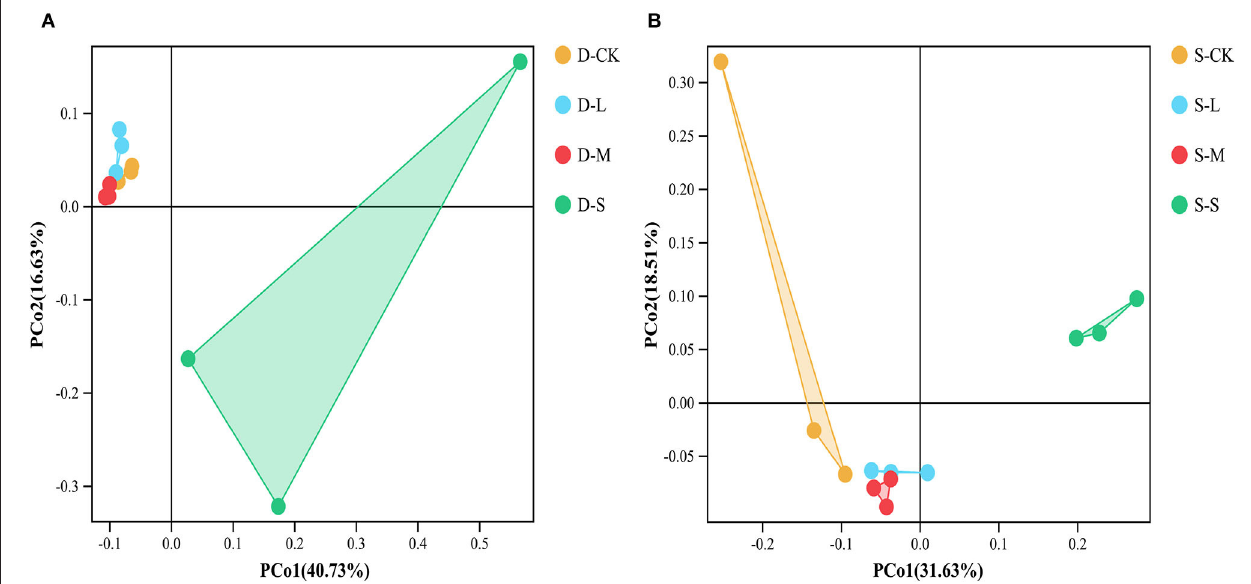
FIGURE 2 | Principal coordinates analysis (PCoA) of the bacterial community composition based on the Bray–Curtis distance among different groups in (A) winter and (B) summer. D-S, small gaps in winter; D-M, medium gaps in winter; D-L, large gaps in winter; D-CK, no forest gaps in winter; S-S, small gaps in summer; S-M, medium gaps in summer; S-L, large gaps in summer; S-CK, no forest gaps in summer.